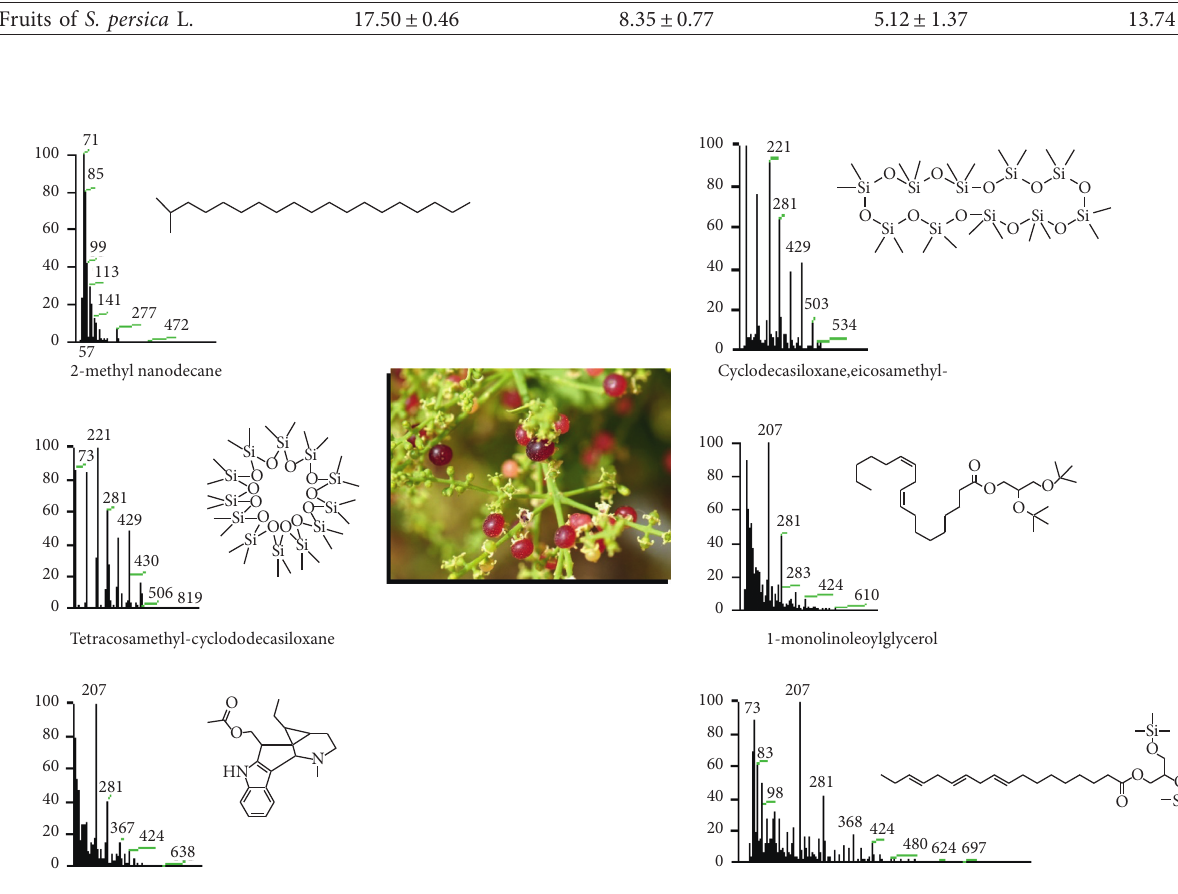
Table 3: Cytotoxic activity of the ethanol extract of the S. persica fruits against three cancer cell lines and one normal fibroblast (MTT 72h IC 50 ± SD μ g/mL). Extract Fruits of S. persica